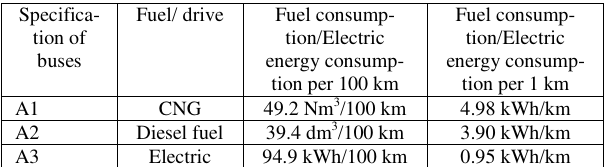
Table 1. Results of consumption of fuel and electrical energy per route in SORT 2 cycle for tested 12-metre buses Specifica- tion of